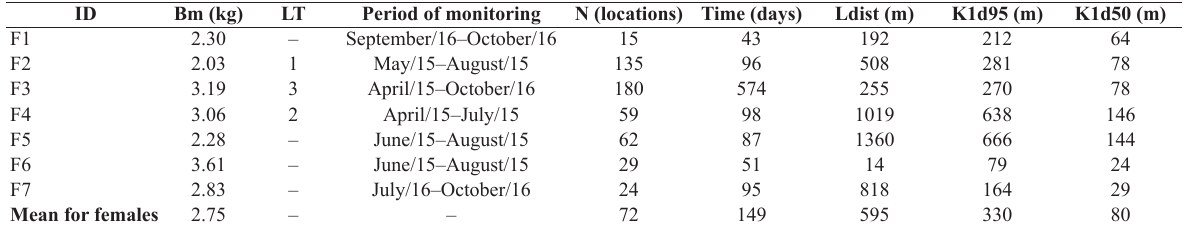
Table 1. Distance travelled by radio-tracked Phrynops geoffroanus females at the studied area (Campo Grande, MS, Brazil). ID – individual; Bm – body mass; LT – locations recorded in terrestrial habitat; N – number of recorded locations; Time – number of days elapsed from first to last recorded location; Ldist – minimum linear home range; K1d95 – 1D Kernel 95%; K1d50 – 1D Kernel 50%; kg – kilograms; m – meters.